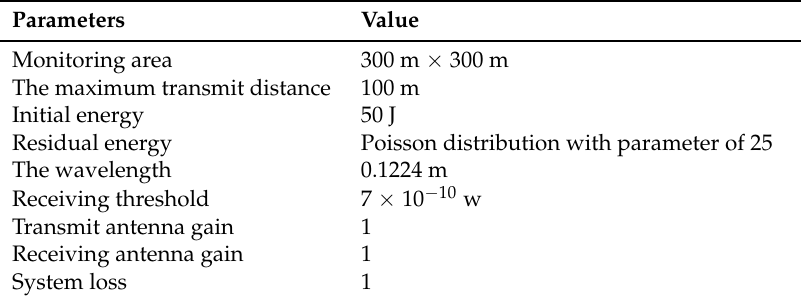
Table 1. Experimental parameters.